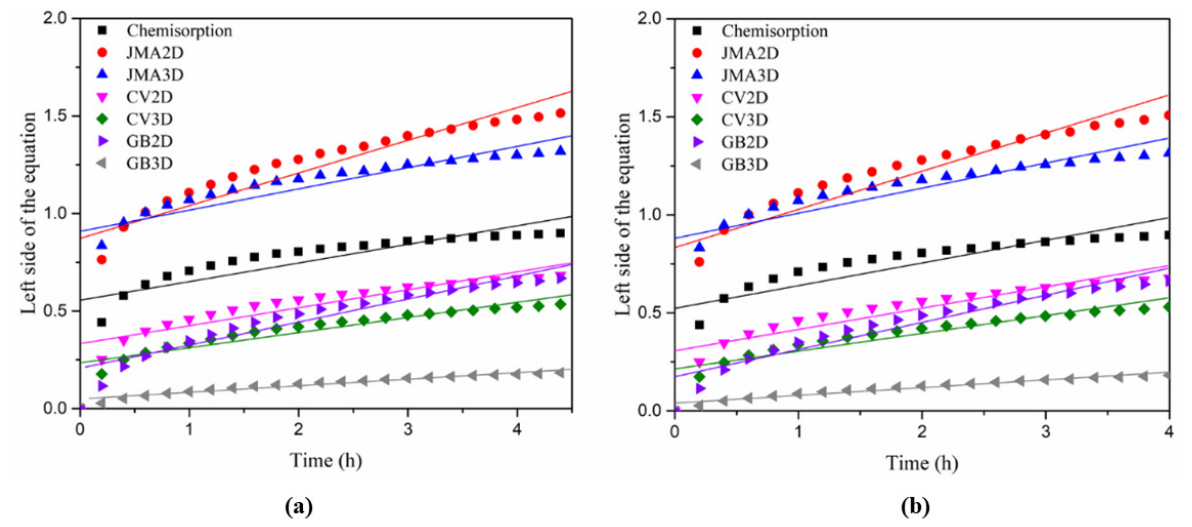
Figure 7. Linear fitting of each rate limiting step model for activated alloys ( a ) 2wt.% Zr + 2 wt.% V; ( b ) 2 wt.% Zr + 2 wt.% V + 2 wt.% Mn. Table 7. Adjusted R 2 value for the linear regression of different kinetic model. Adjusted R